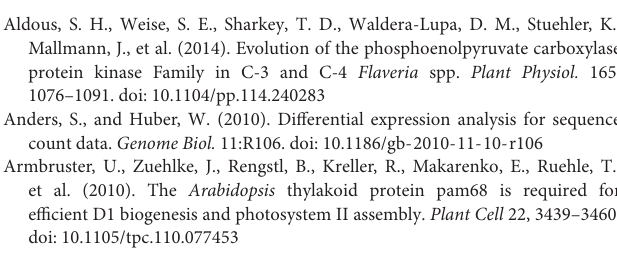
FIGURE S1 | The zeatin biosynthesis pathway enriched by KEGG analysis. Gene/protein names in a red and blue box represent up-regulation and down-regulation under heat stress, respectively. EC:2.5.1.27, 2.5.1.112, adenylate dimethylallyltransferase (IPT, cytokinin synthase); EC:2.4.1.215, cis -zeatin O -glucosyltransferase ( Cis -ZOG); EC:2.5.1.75, tRNA dimethylallyltransferase. FIGURE S2 | The mTOR (mammalian target of rapamycin) signaling pathway enriched by KEGG analysis. Gene/protein names in a red and blue box represent up-regulation and down-regulation under heat stress, respectively. EC:2.7.11.1, serine/threonine-protein kinase mTOR. FIGURE S3 | Linear regression analysis between Quantitative Real-Time PCR (qRT-PCR) and RNA-seq results ( r 2 = 0.8739) for 16 genes. X -axis numbers represent the fold change values of qRT-PCR results. Y -axis numbers represent the fold change values of RNA-seq results. FIGURE S4 | qRT-PCR verification of the 16 randomly selected DEGS (differentially expressed genes). Error bars indicate standard